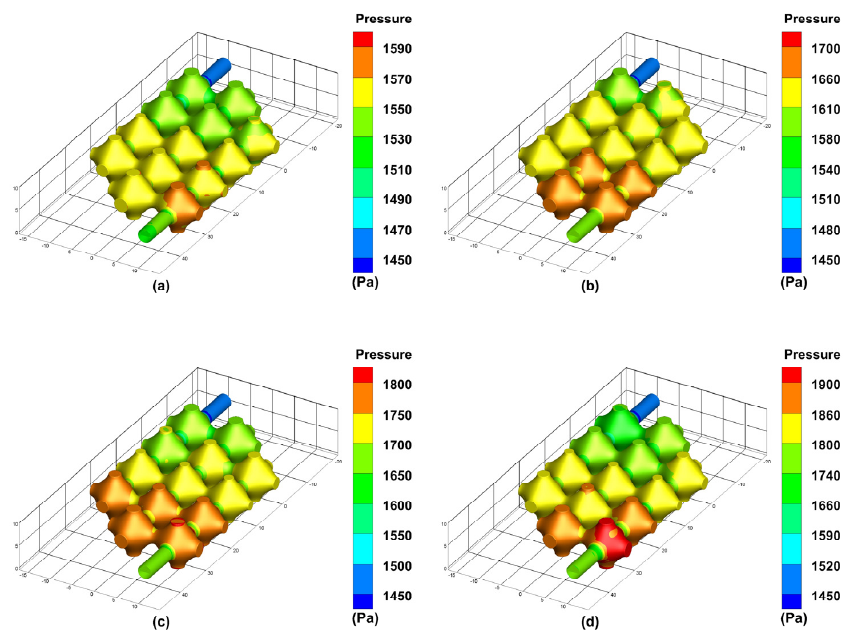
Figure 9. Simulated wall pressure results of the vascular-like flow channels at different perfusion pressures after optimisation: ( a ) 12 mm Hg; ( b ) 13 mm Hg; ( c ) 14 mm Hg; ( d ) 15 mm Hg.